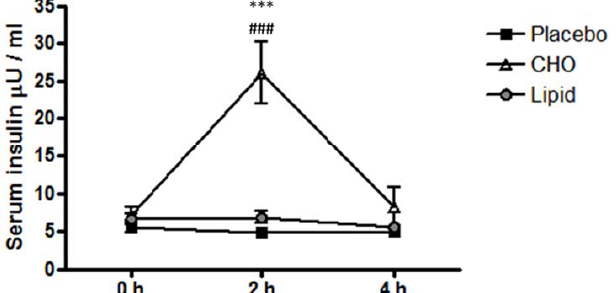
Table 1. Participants’ baseline